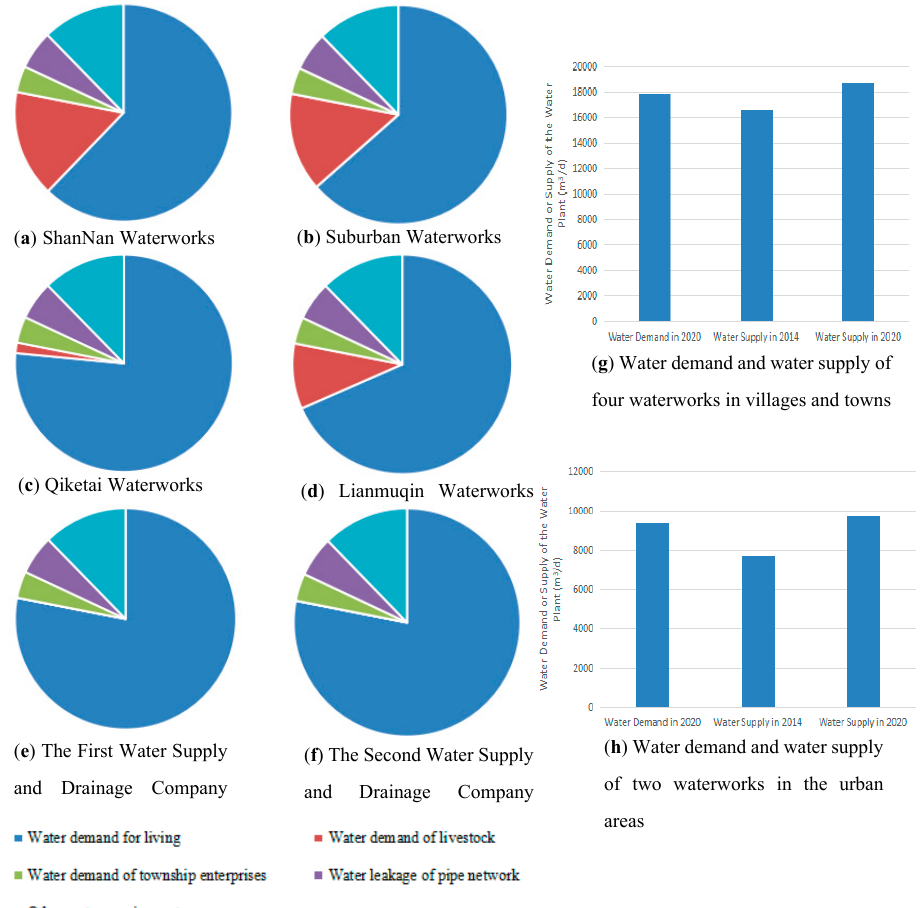
Figure 5. Water supply and demand prediction in 2010 for the six waterworks of Shanshan County.